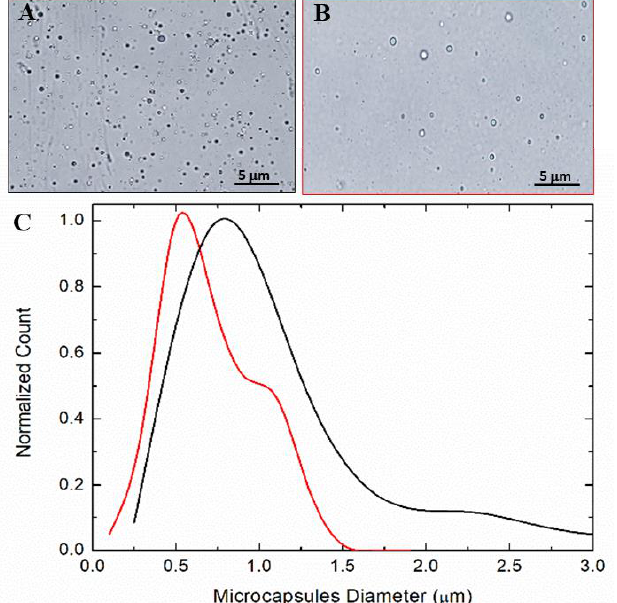
Figure 7. Optical microscopy images of OG mc obtained using 10 mg/mL and 50 μL soybean oil: ( A ) immediately after preparation and ( B ) after one month. ( C ) Comparison between the normalized size distributions of OG mc at day one (black) and one month later (red).